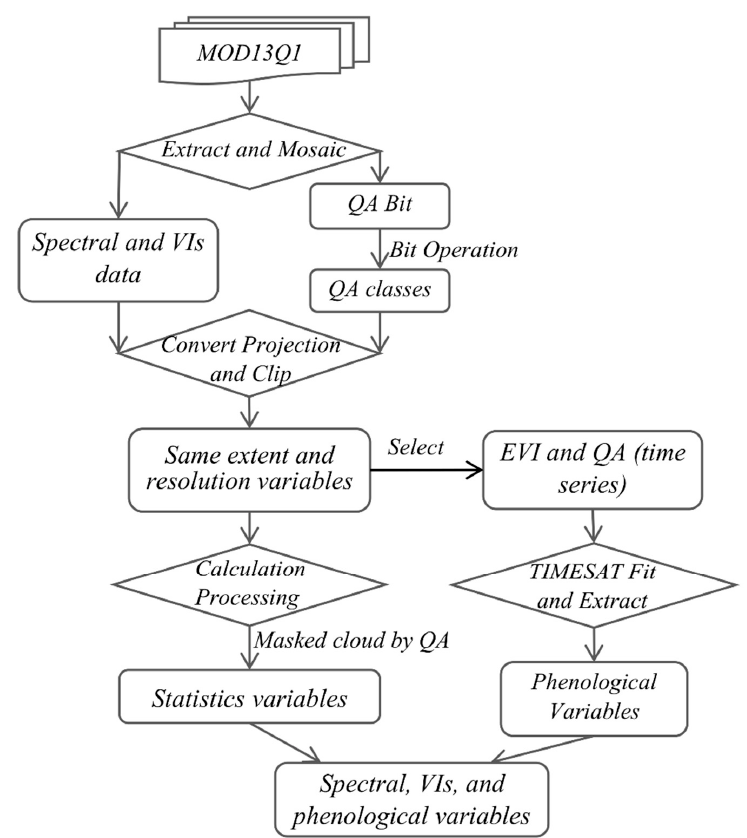
Figure A1. Flowchart on processing predictor variables. QA, quality control; VI, vegetation indices; EVI, Enhanced Vegetation Index; Squares, source data and processed data; Diamonds, operations; Arrows, processing directions.